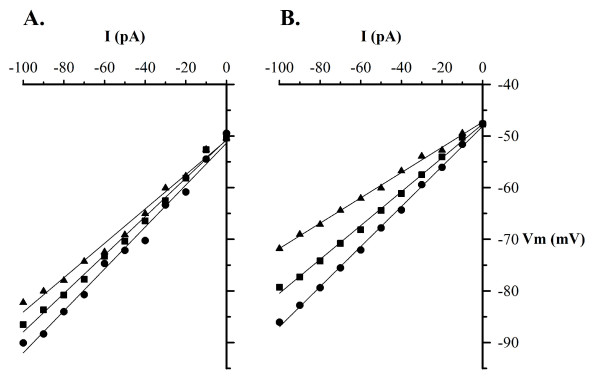
The effects of PGE2 on the input resistance of a VMPO temperature insensitive neuron (A) and a VMPO warm sensitive neuron (B). For each, changes in membrane potential are plotted in response to a series of hyperpolarizing current pulses (-10 to -100 pA, 200 ms), during baseline conditions (●), perfusion with PGE2 (▲), and after PGE2 has been washed out of the chamber (■). For the temperature insensitive neuron in A (m = 0.05), input resistance decreased from a baseline of 406.33 MΩ, to 332.40 MΩ during perfusion with PGE2. After PGE2 had been washed out of the chamber, input resistance increased to 372.32 MΩ. For the warm sensitive neuron in B (m = 1.30), input resistance decreased from a baseline of 388.00 MΩ, to 244.86 MΩ during perfusion with PGE2. After PGE2 had been washed out of the chamber, input resistance increased to 327.63 MΩ.